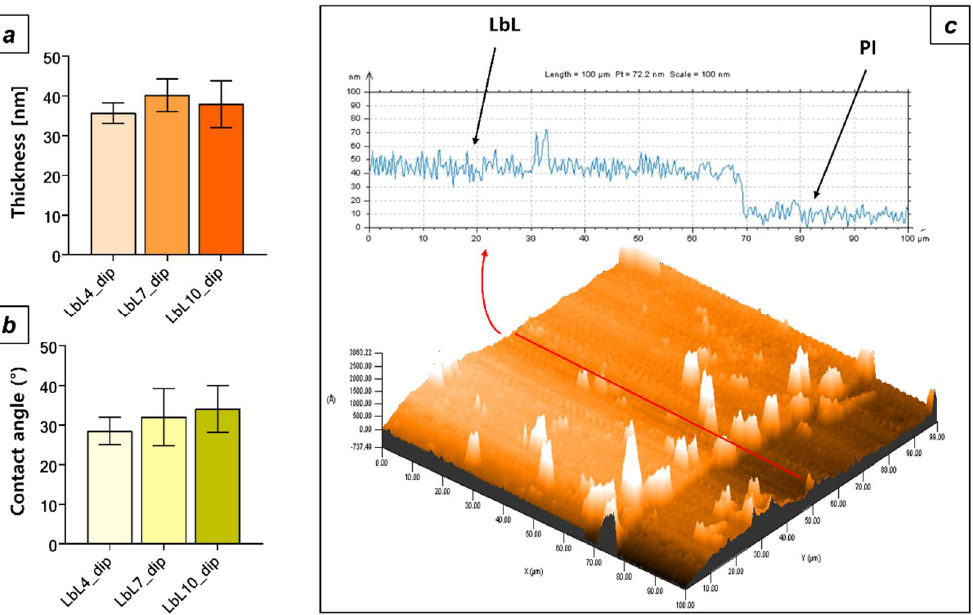
Figure 3. LbL assembly by dip coating. Thickness data ( a ) and CA values ( b ) of LbL assembly onto PI surface after the deposition of 4 (LbL4_dip), 7 (LbL7_dip), and 10 (LbL10_dip) polysaccharide bilayers. ( c ) 3D reconstruction of a 100 μm × 100 μm surface profilometry referred to a LbL10_dip sample and plot of surface roughness profile relative to the red line across the scratch showing the presence of an LbL multilayer coating on the surface of the PI.